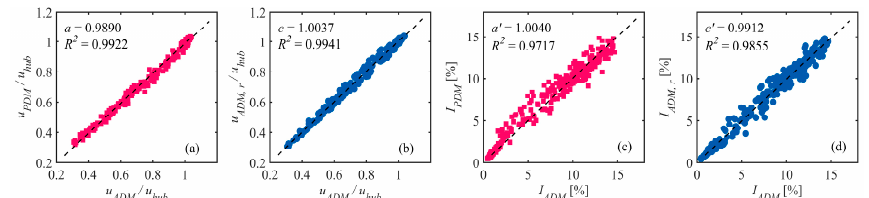
Figure 18. Evaluation of the experimental uncertainty under the UIF condition. ( a ) and ( c ) represent the mean wake velocity and turbulence intensity, respectively, under different driving modes. ( b ) and ( d ) represent the experimental results under the same driving mode (ADM).